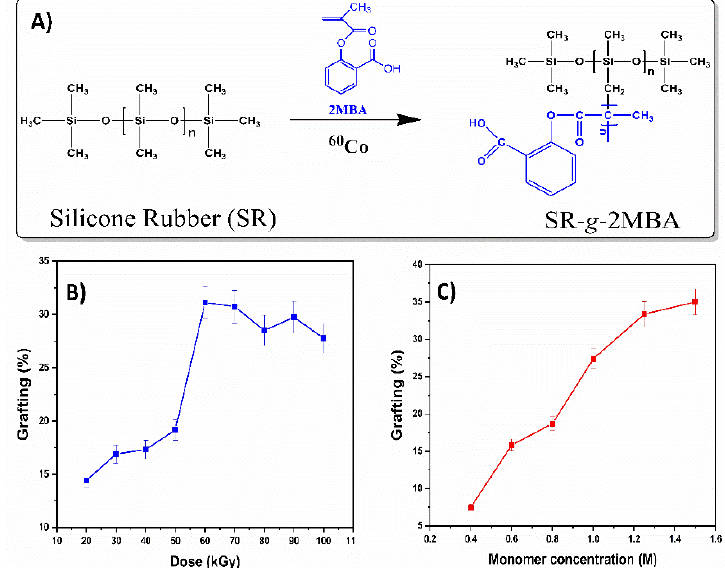
Figure 1. ( A ) Schematic representation of 2MBA grafting onto silicone rubber (SR); dependence of grafting percentage on ( B ) absorbed dose and ( C ) monomer concentration.